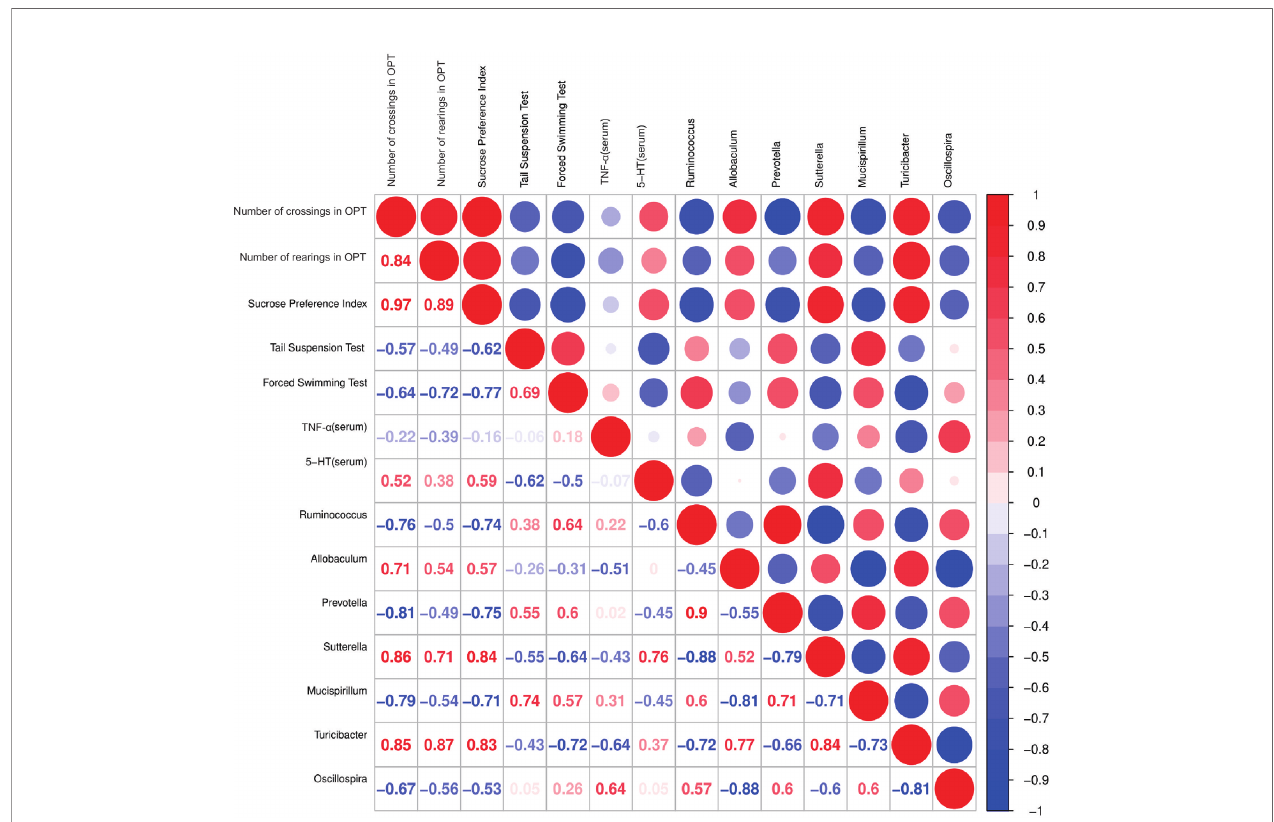
FIGURE 9 | Correlation analysis between behavioral results, serum 5-HT, TNF- a levels and abundance of signature gut microbiota. Spearman ’ s correlation analysis was performed by data of the LPS group and CAP+LPS group (n = 8). In the upper right corner, the color and size of the circle denote the strength of correlation, red is positive, and blue is negative. The corresponding correlation numeric data could be found in the lower left